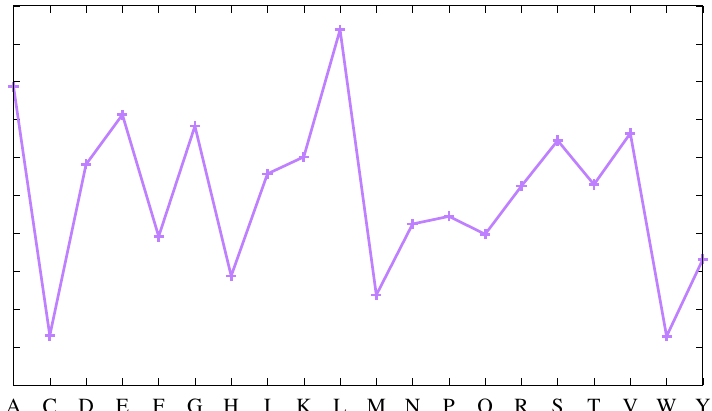
Figure 1. Average abundance, ¯ f a ( a ) (cf. Equation (3)), of amino acid a , in the protein set used. The values are given in percentage of the total number of amino acids (see